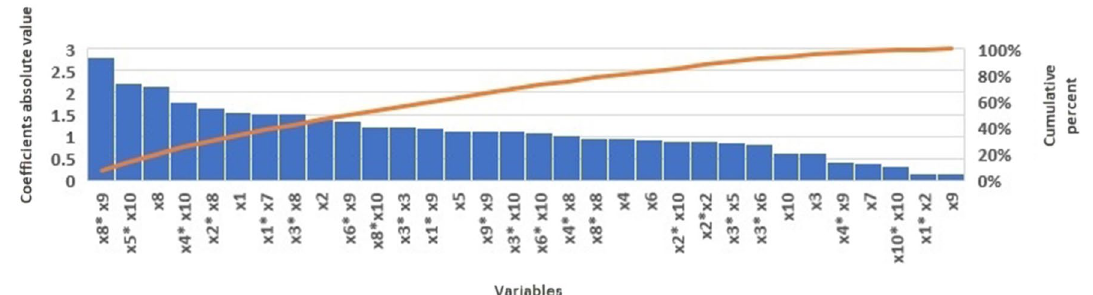
Fig. 7 The Pareto diagram of the coefficients’ absolute value for the first interval